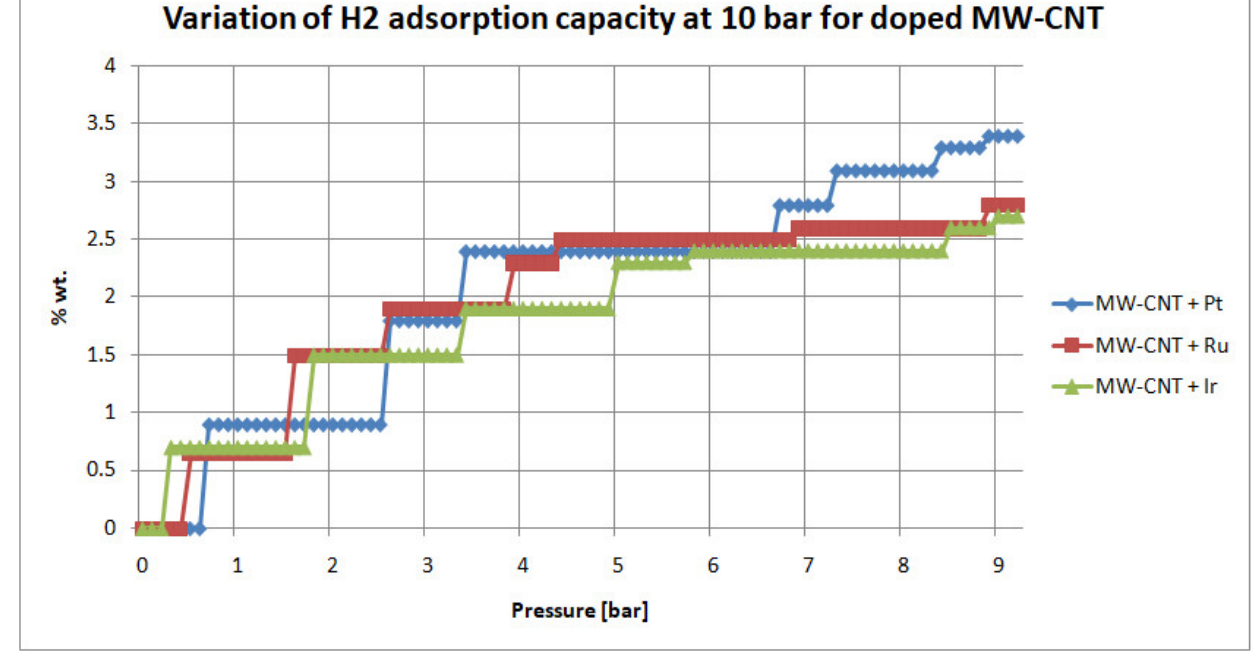
Figure 5. Metal-doped MW-NT H 2 -adsorption-capacity determination at 10 bar.